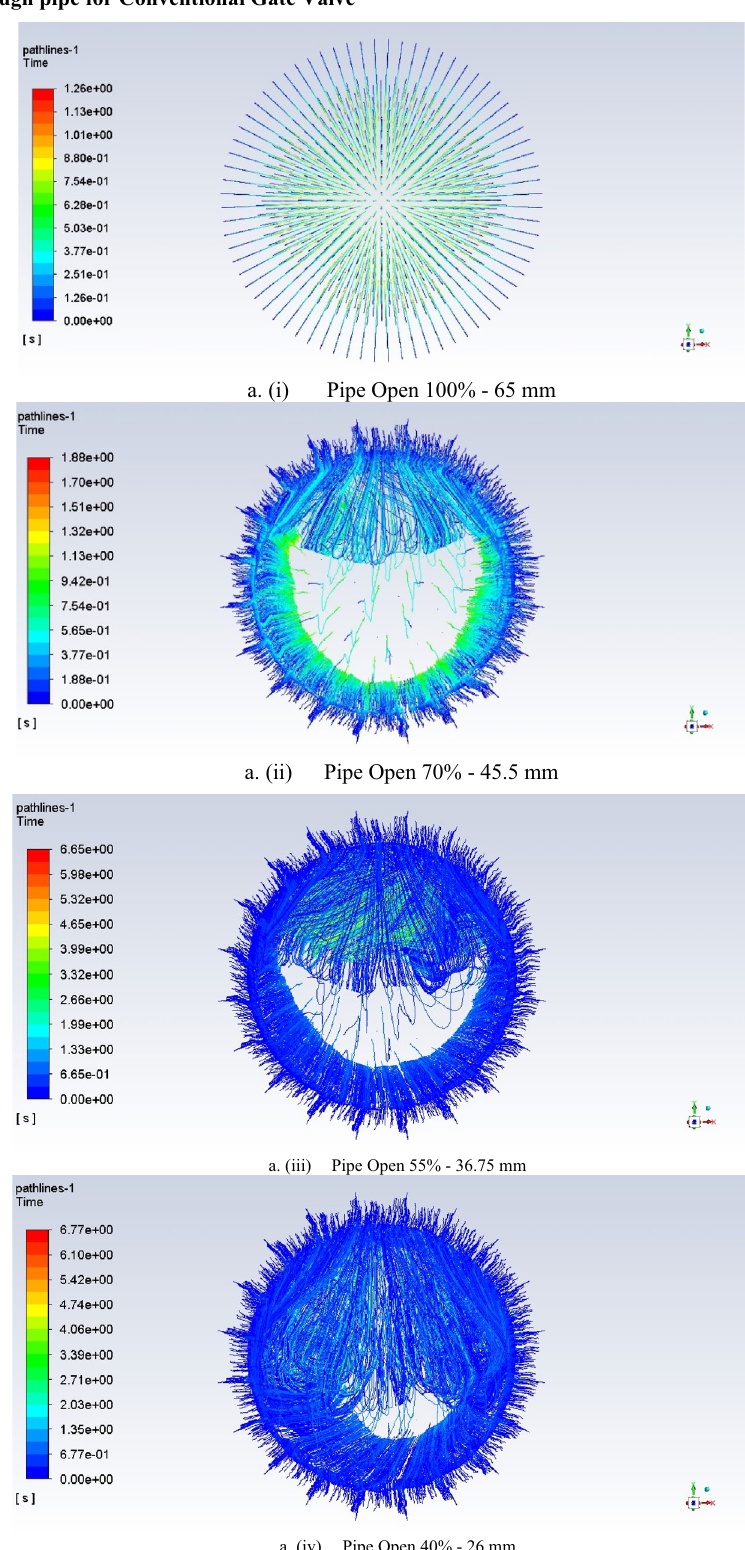
(a) Flow through pipe for Conventional Gate